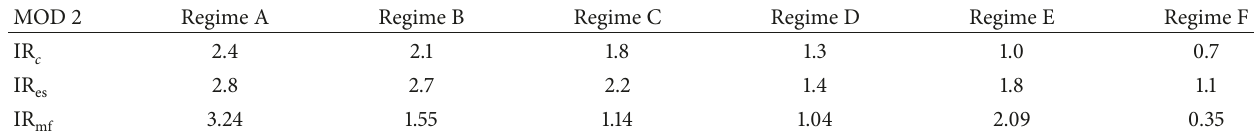
Table 11: Simulation results of MOD 2.